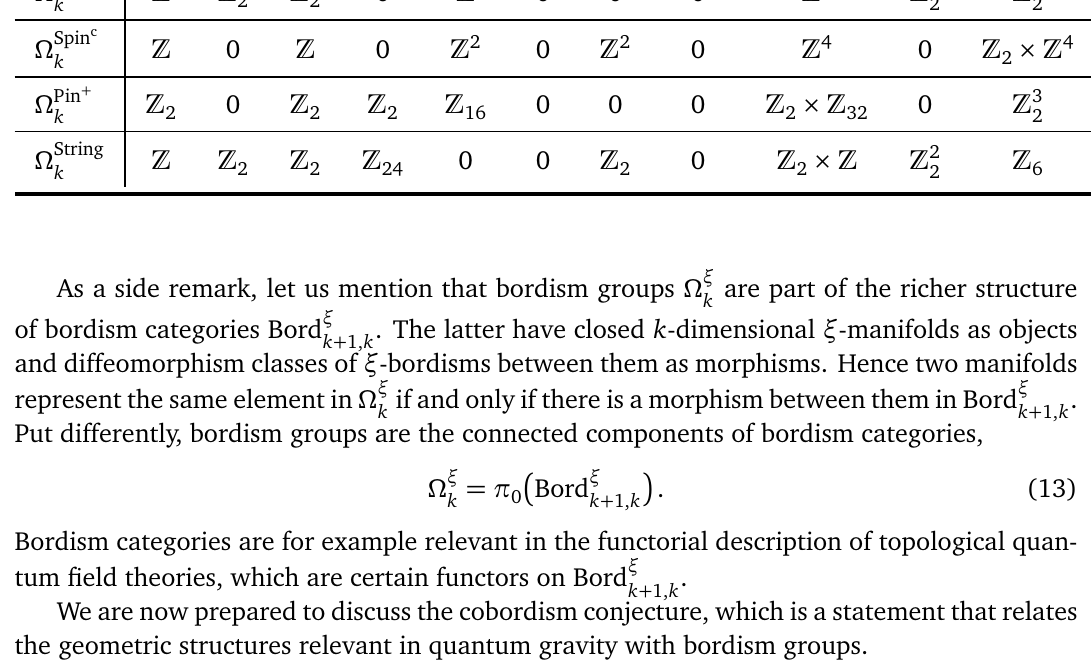
Table 1: Bordism groups Ω